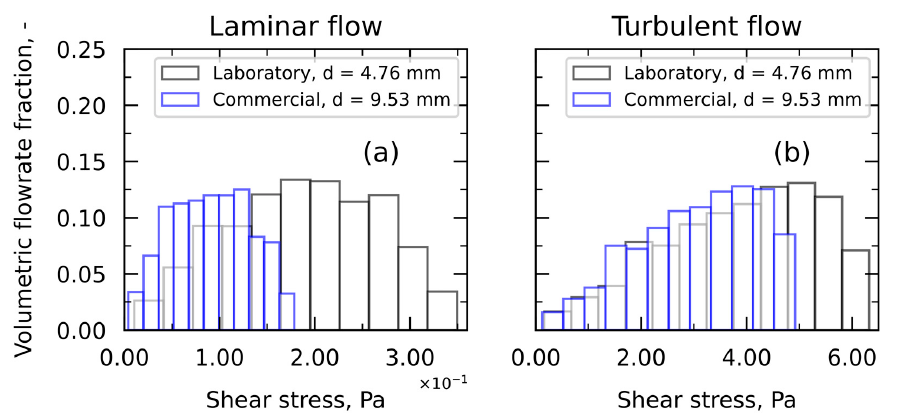
Figure 8. Shear stress distribution weighted on normalized volumetric flowrate for commercial (blue histogram) and laboratory (black histogram) unit following application of Approach 2 for laminar flow ( a ) and turbulent flow ( b ).